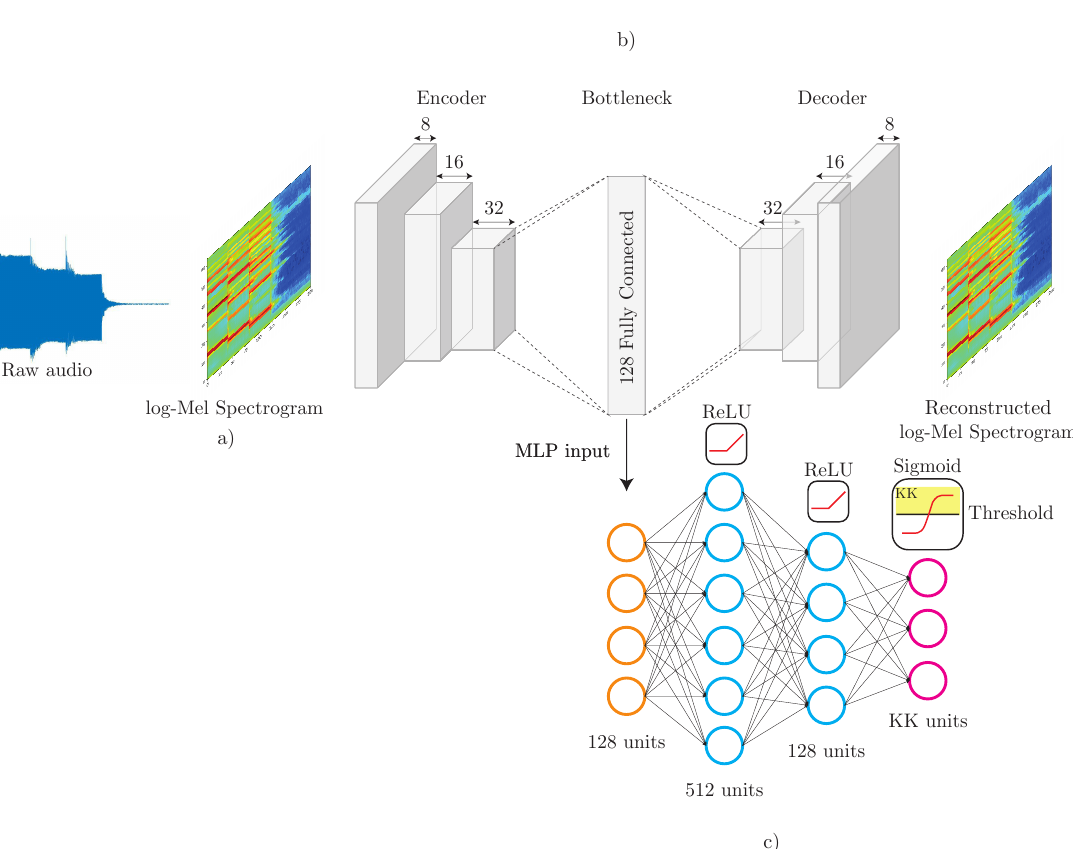
Figure 1. Proposed open-set recognition (OSR)/few-shot learning (FSL) framework for audio classification. In this scheme, an unsupervised autoencoder is considered. ( a ) Log-Mel spectrogram representation. ( b ) Autoencoder. ( c ) multi-layer perceptron (MLP)